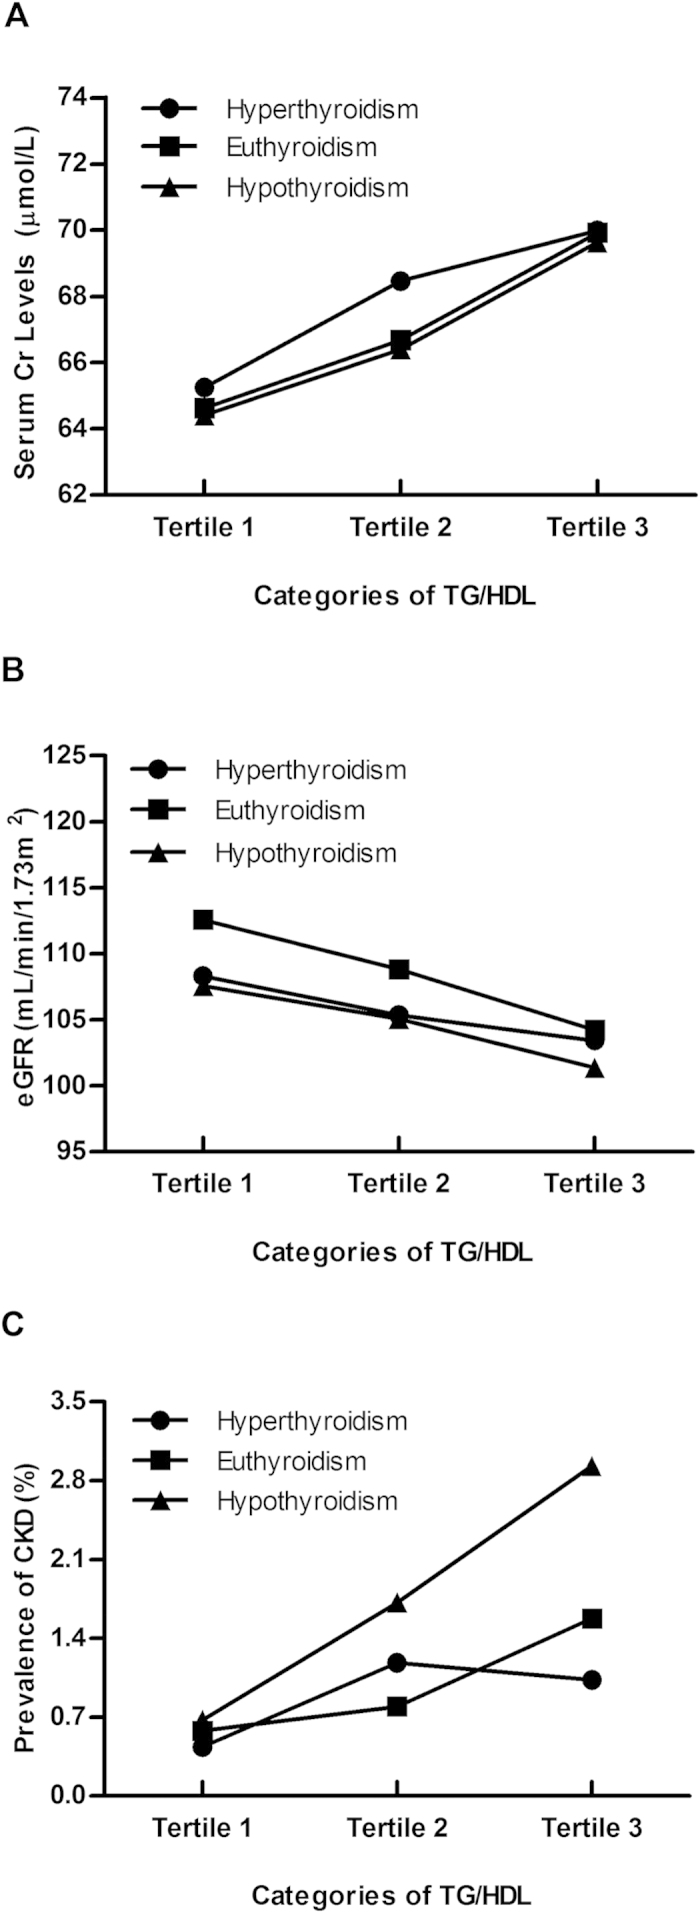
Correlation of TG/HDL with renal function according to thyroid function status.The data are presented as the means (Cr and eGFR) or prevalence (CKD status). The tertile ranges are as follows: Tertile 1 (<0.79), Tertile 2 (0.79–1.38), Tertile 3 (>1.38). TG, triglyceride; HDL, high-density lipoprotein; Cr, creatinine; eGFR, estimated glomerular filtration rate; CKD, chronic kidney diseases.